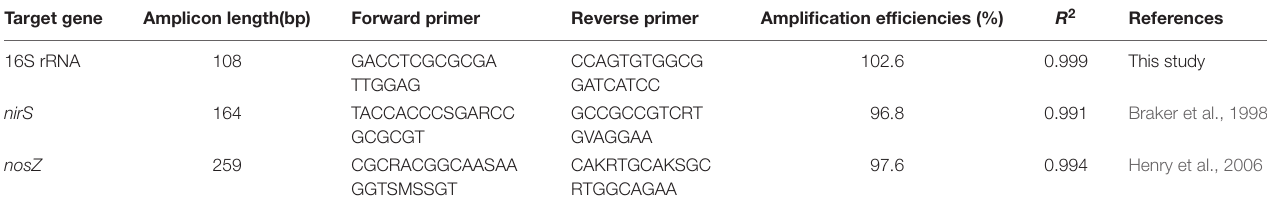
FIGURE 1 | Time series of NO 3 − , NO 2 − and measured N 2 during denitrification with three different denitrifying Thauera strains (K172, NS1 and TK001) in batch cultures amended with ∼ 0.9 mmol L − 1 NO 3 − and acetate. Error bars represent the standard errors for three to four microcosm replicates. The dashed line indicates the N 2 concentrations calculated assuming decreases in initial NO 3 − -N concentrations are completely reduced to N 2 . TABLE 3 | Sequences of primers used for quantitative PCR (qPCR) and parameters of calibration curves used for qPCR analysis. Target gene Amplicon length(bp) Forward